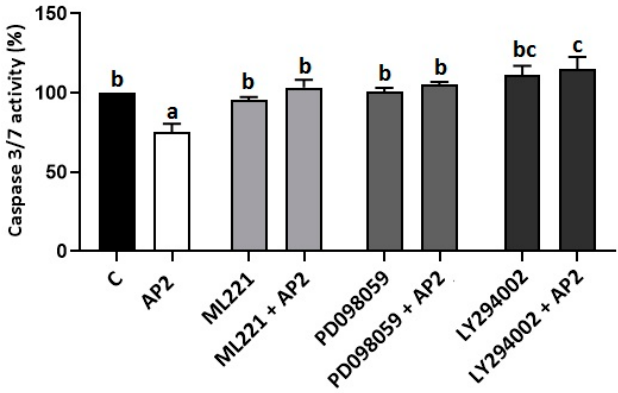
Figure 4. Involvement of APJ receptor, mitogen-activated protein kinase (ERK1/2/MAP3/1) and protein kinase B (AKT) in the antiapoptotic effect of apelin in BeWo cells: The cells were pre-treated for 1 h with APJ receptor, MAP3/1 and AKT kinase inhibitors ML221 (5 µM), PD098059 (1 µM) and LY290042 (1 µM). Subsequently, apelin at a dose of 2 (AP2) ng/mL was added. After 72 h of incubation, activity of caspase 3 and 7 was analysed using the Caspase-Glo 3/7 assay. Experiments were independently performed and repeated three times ( n = 3). The results are presented as a percentage compared to the control (100%). The data are arranged as means ± SEM. Different letters indicate significant differences ( p < 0.05) among groups; Control (C). To confirm the results obtained from BeWo cells, we performed additional experi- ments on primary cultures of villous explants from the third trimester of human preg- nancy. Villous explants were incubated with apelin at doses of 2 and 20 ng/mL for 24, 48 and 72 h, and DNA fragmentation was analysed. As shown in Figure 5, apelin signifi- cantly decreased the histone-associated DNA fragment level for each incubation time at both apelin doses ( p < 0.05, Figure 5).